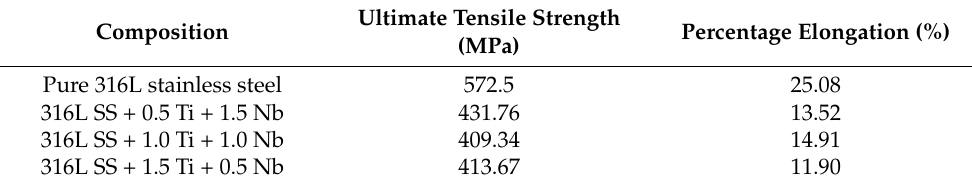
Table 4. Tensile test results of sintered samples.